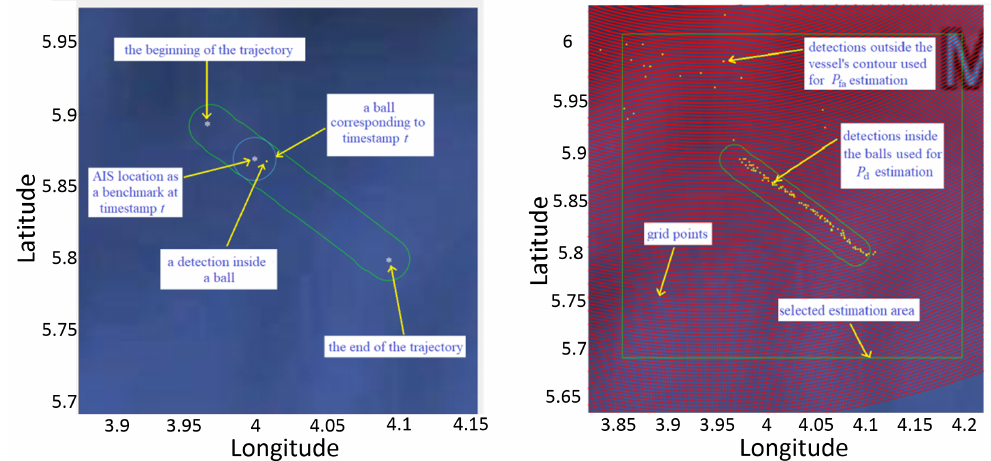
Figure 26. The forming of the ball ( left ) and the selection of the estimation area around the vessel’s contour ( right